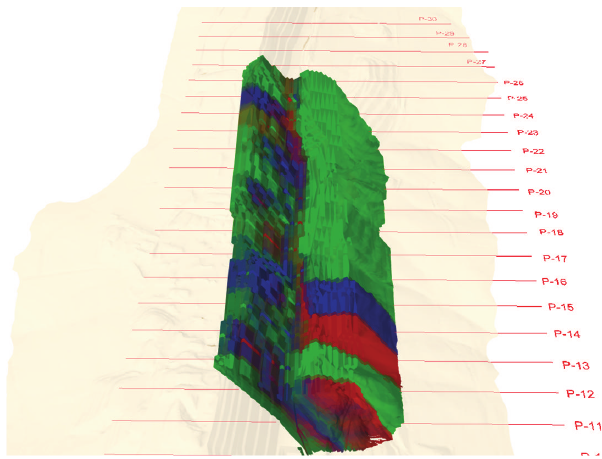
Figure 4: Three-dimensional model of the site with the predictions of grade distributions [silicon metal (blue), ferrosilicon (red), aggre- gate (green), and kaolin (yellow)] and the terrain.